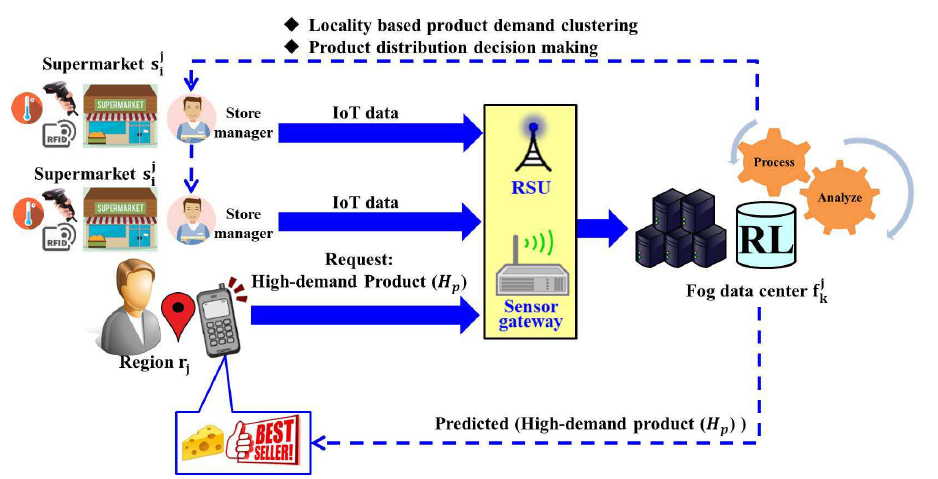
Figure 2. Prediction and decision making in fog computing